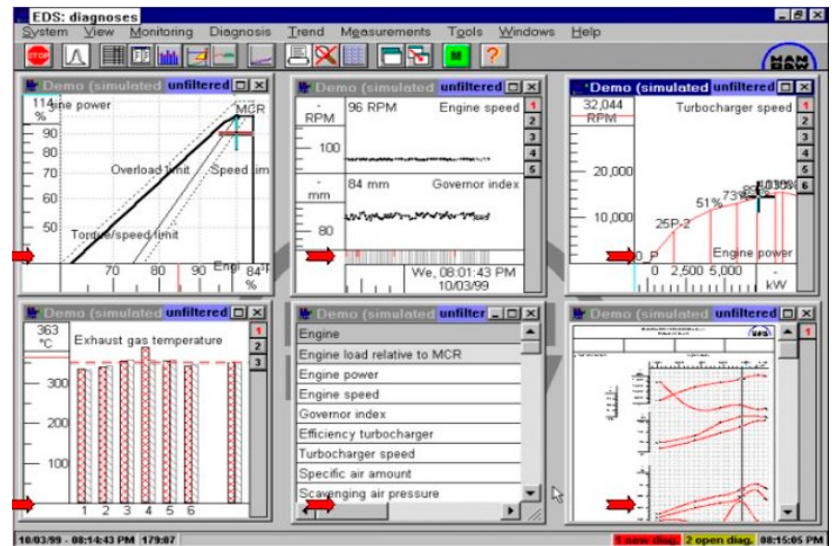
Figure 7. Complicated graphs of mathematical dependencies (at the level of higher mathematics, e.g., nonlinear functions) showing trends in changes of engine condition, on the basis of analysis of data provided by sensors placed on the engine, requiring [48].